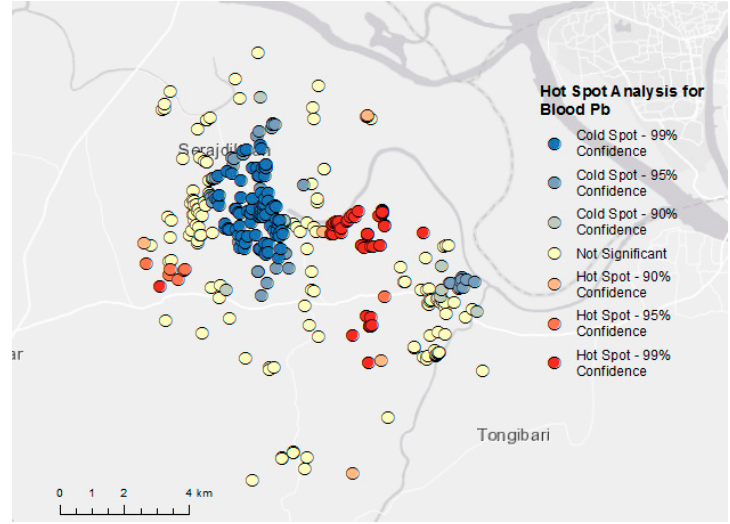
Figure 3. Hot spot analysis using Getis Ord-Gi(d) statistic indicating hot and cold spots and their confidence levels for cohort member blood lead levels.